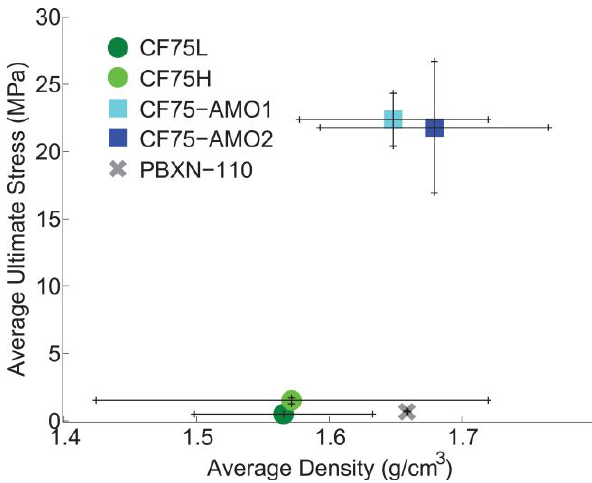
Figure 3. Ultimate compressive stress as a function of density for the four formulations, compared to PBX 9501 and PBXN-110.